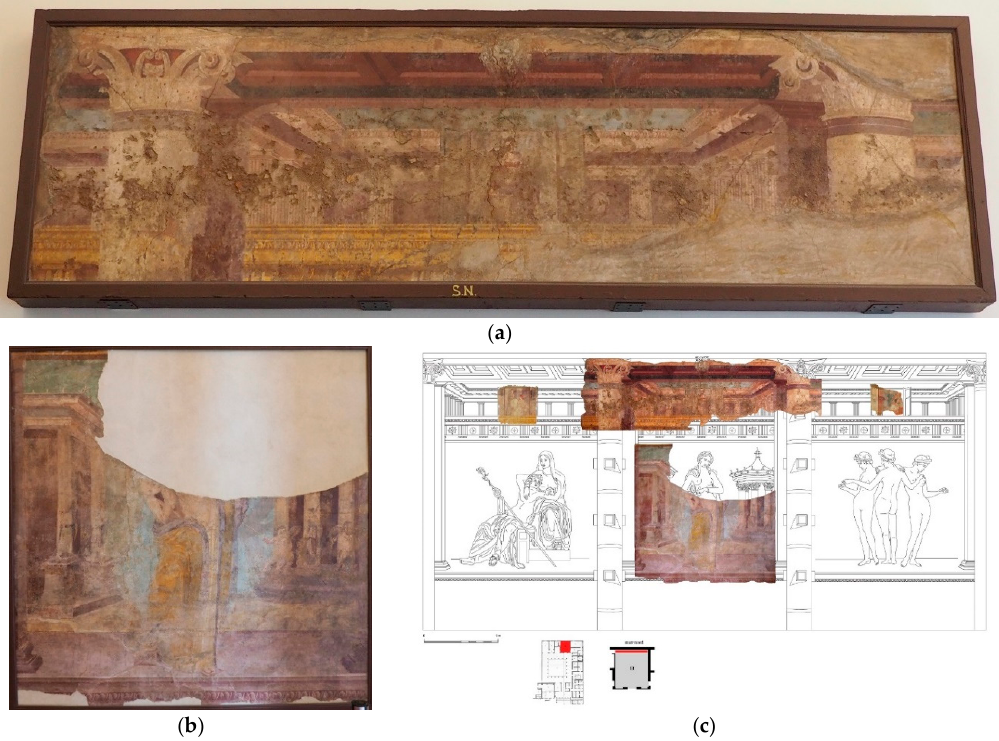
Figure 4. ( a , b ) Fragments of the upper and lower part of the central panel of the northern wall (facing